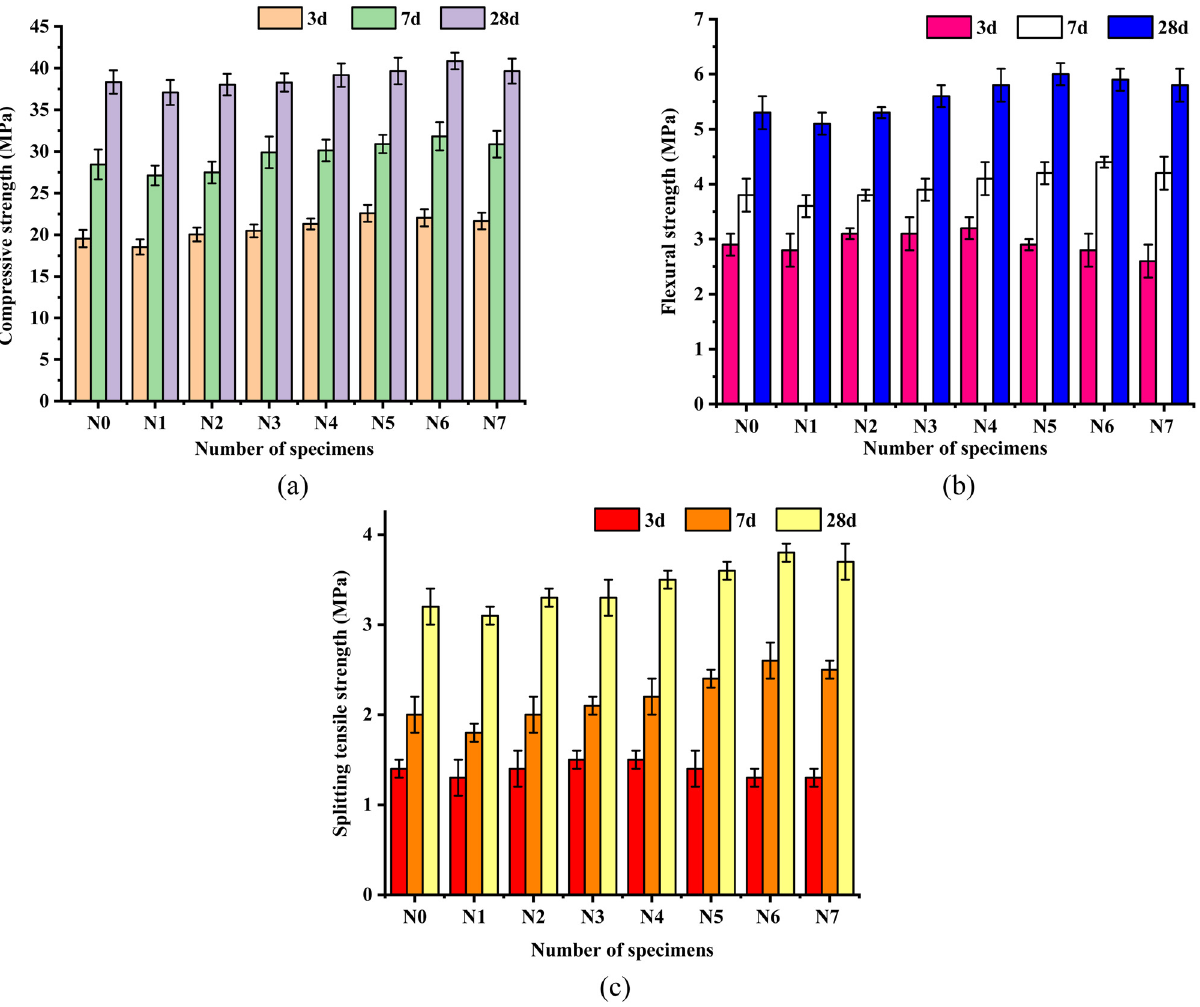
Figure 5: Mechanical properties of concrete at di ff erent ages. ( a ) Compressive strength. ( b ) Flexural strength. ( c ) Splitting tensile